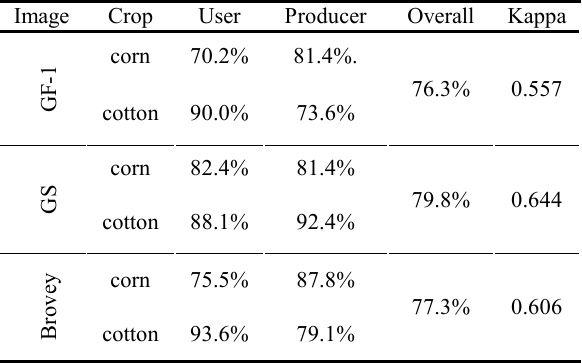
Table 4. The accuracy assessments for dryland crop classification with different